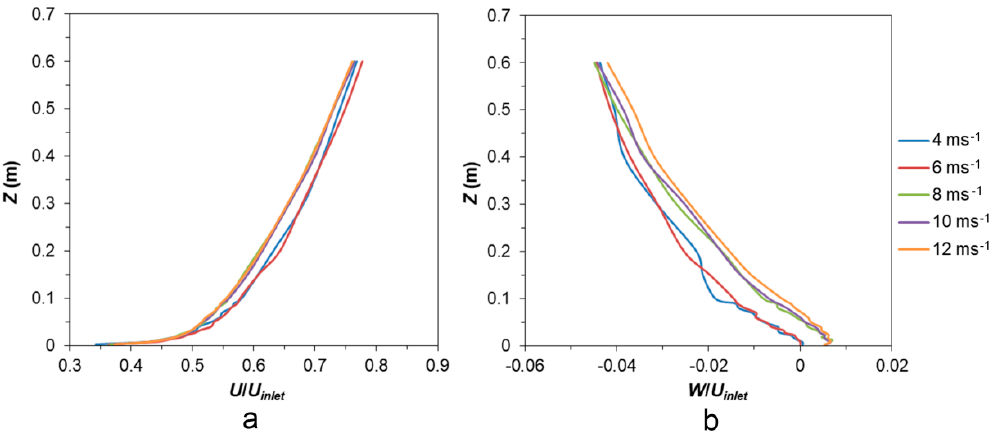
Figure 5. Dimensionless streamwise ( U / U inlet ) ( a ) and vertical ( W / U inlet ) ( b ) air velocity profiles of the incident flow in the vertical direction ( Z ) at the wind tunnel inlet wind speed ( U inlet ) of 4, 6, 8, 10, and 12 m·s − 1 .